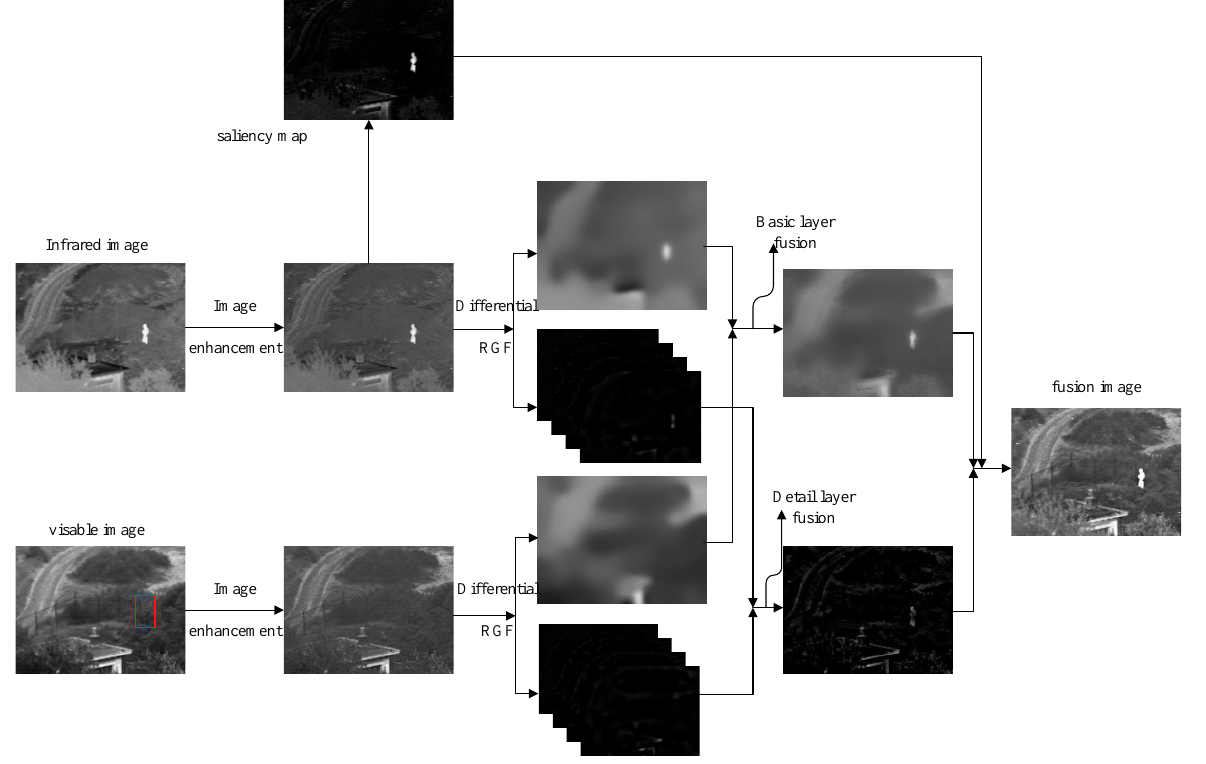
Figure 1. Infrared and visible image fusion frame diagram. The red rectangle frames the visible image where the person is